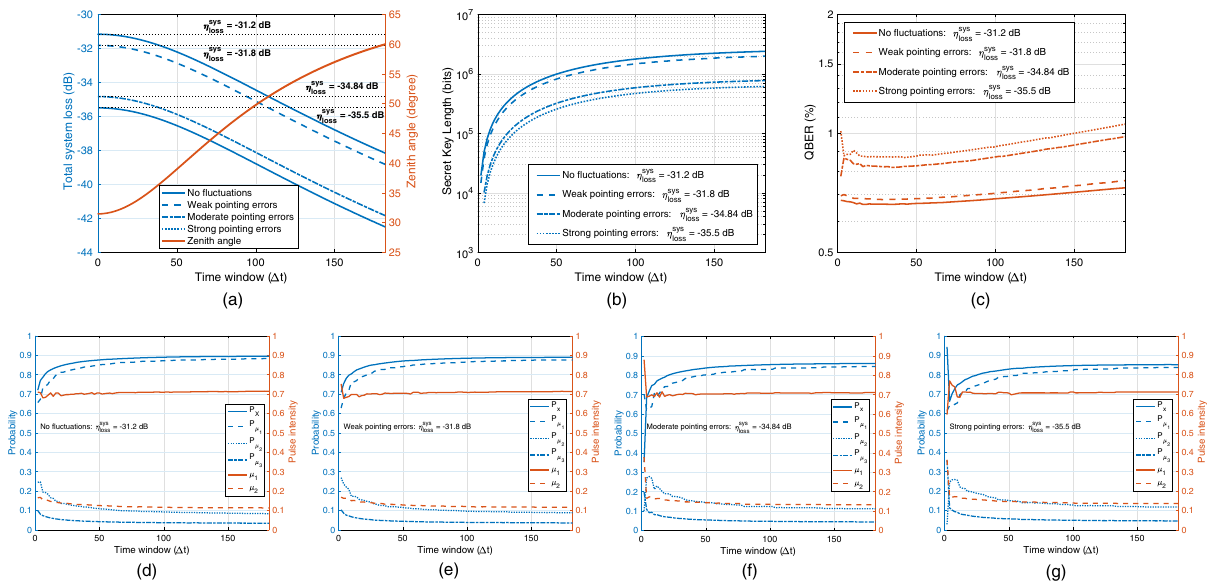
Fig. 7 Performance of the LEO-to-ground quantum key distribution system. The quantum bit error rate (QBER) and secret-key length (SKL) are investigated for a decoy-state ef fi cient BB84 QKD protocol with fi nite-key analyses. The time window duration denoted as Δ t is de fi ned as the transmission half-window duration t 0 + Δ t where t 0 = 0 represents the time instant corresponding to the lowest zenith angle. In a , the total system loss given in Fig. 6c is re-presented versus the time window duration Δ t of 182 s, and the η sys values corresponding to systems affected by different physical conditions are also loss added. The solid, dashed, dashed-dotted, and dotted navy-blue curves indicate losses under no fl uctuations, weak, moderate, and strong pointing errors, respectively. In b - c , SKL and QBER are shown as a function of Δ t for different η sys values, respectively. For each value of Δ t , the SKL extractable from loss received data within the full-window duration of 2 Δ t is optimized over protocol parameters de fi ned in Table 2. The solid, dashed, dashed-dotted, and dotted navy-blue and orange curves indicate the SKL and QBER under no fl uctuations, weak, moderate, and strong pointing errors, respectively. In d – g , we respectively show the optimized parameters as a function of Δ t for different physical link conditions including no fl uctuations, weak, moderate, and strong pointing errors. The solid, dashed, dotted, and dashed-dotted navy-blue curves indicate parameters P X , P μ , P μ , P μ , respectively. The solid and dashed 1 2 3 orange curves indicate parameters μ 1 and μ 2 , respectively. All parameters are de fi ned in Table